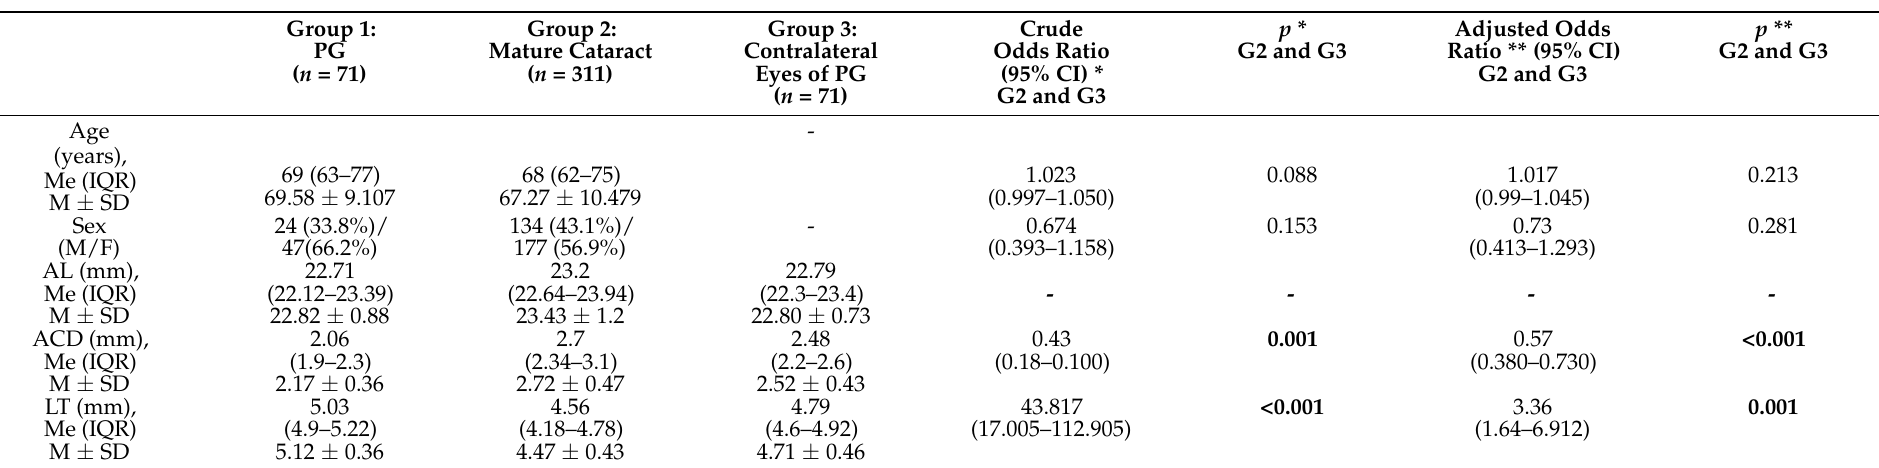
Table 2. A-scan Parameters in Phacomorphic Eyes, Contralateral Eyes of Phacomorphic Glaucoma, Eyes with Mature Cataract, and Results of Logistic Regression Analysis for Group G2 and G3.